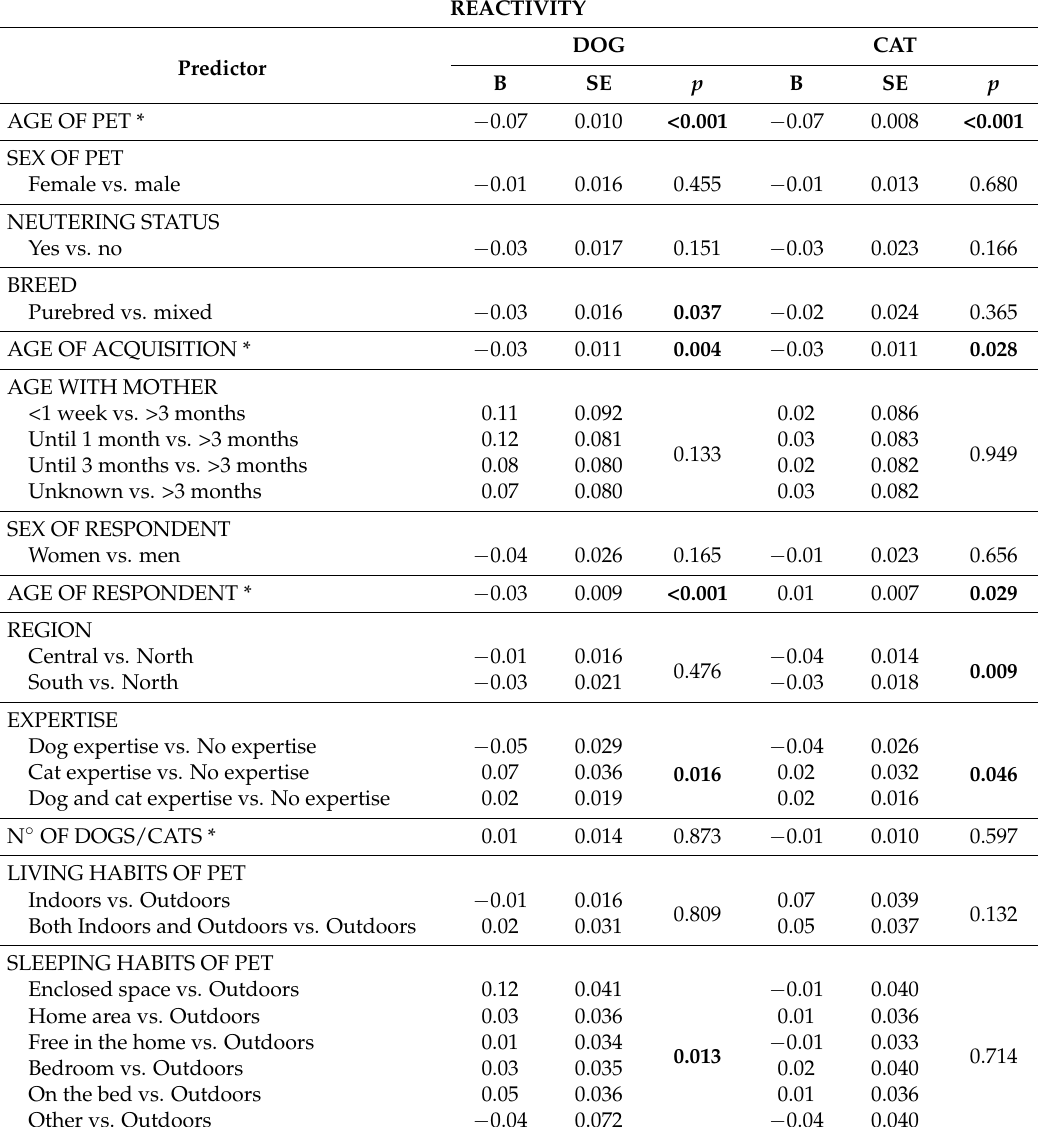
Table 4. Multivariate regression analysis for reactivity in dogs and cats living in the same